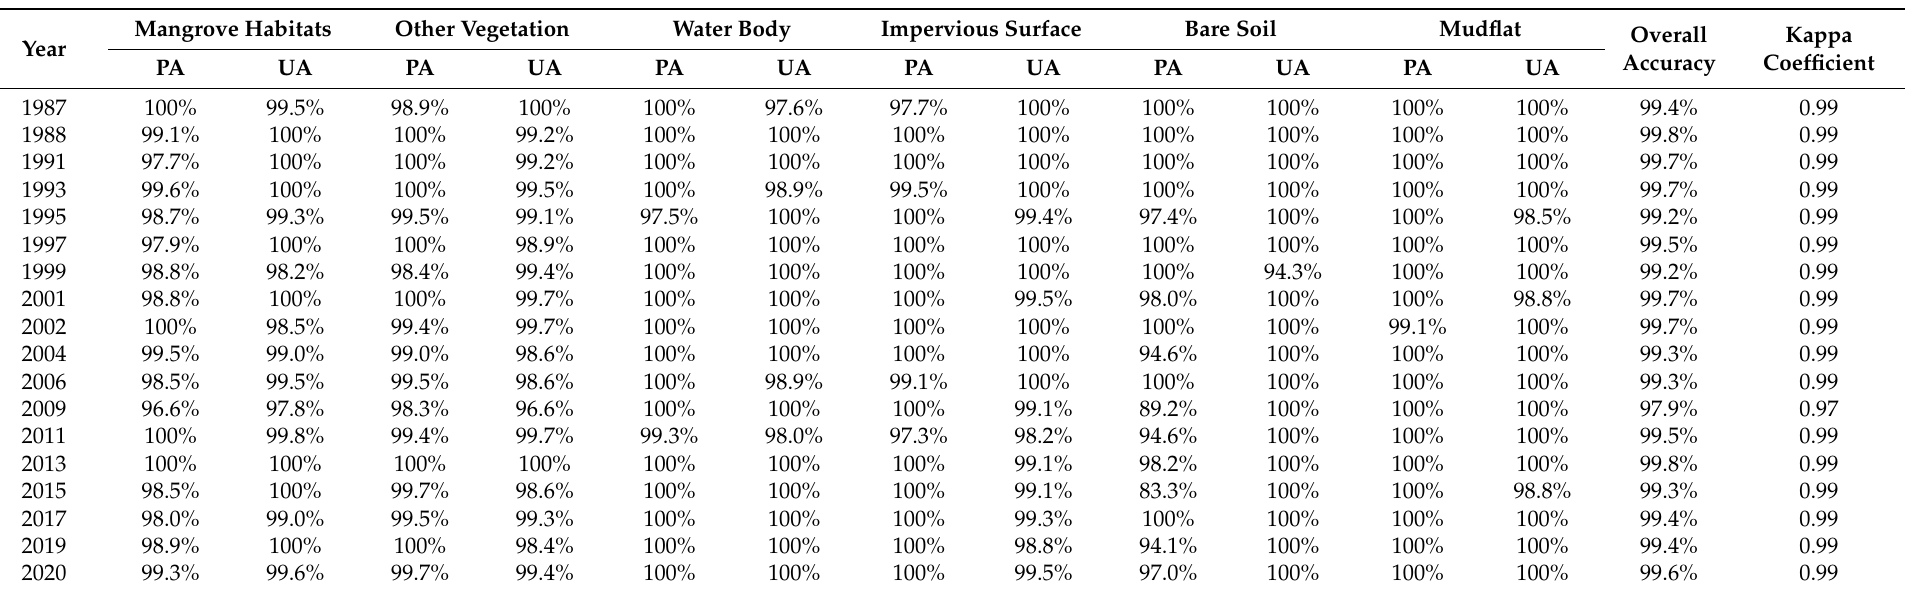
Table 4. Results of the model-based accuracy assessment (PA: producer’s accuracy; UA: user’s